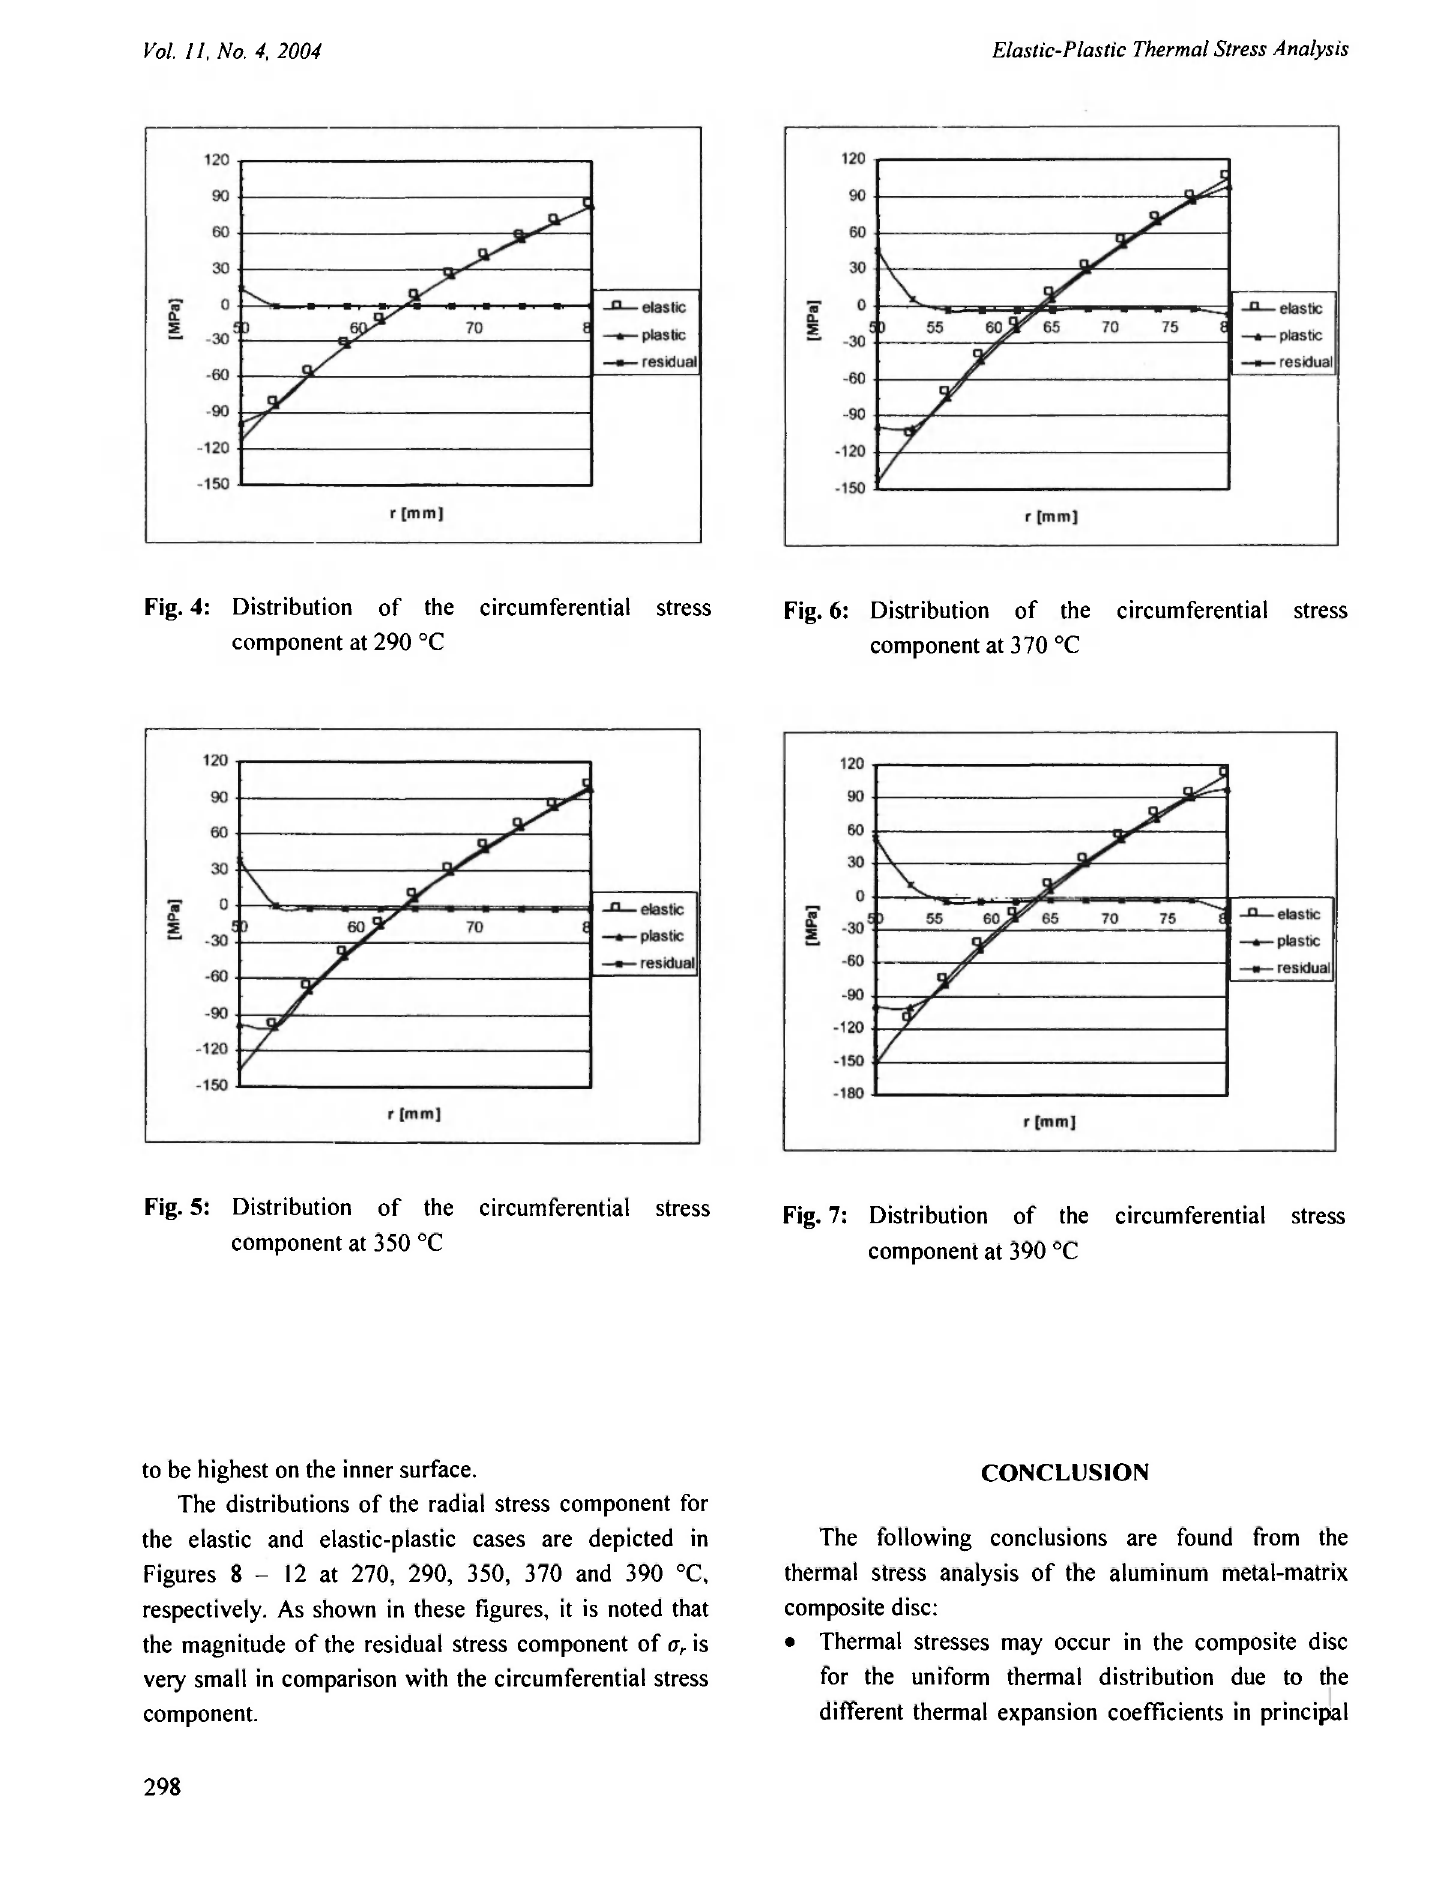
Fig. 6: Distribution of the circumferential stress component at 370 °C